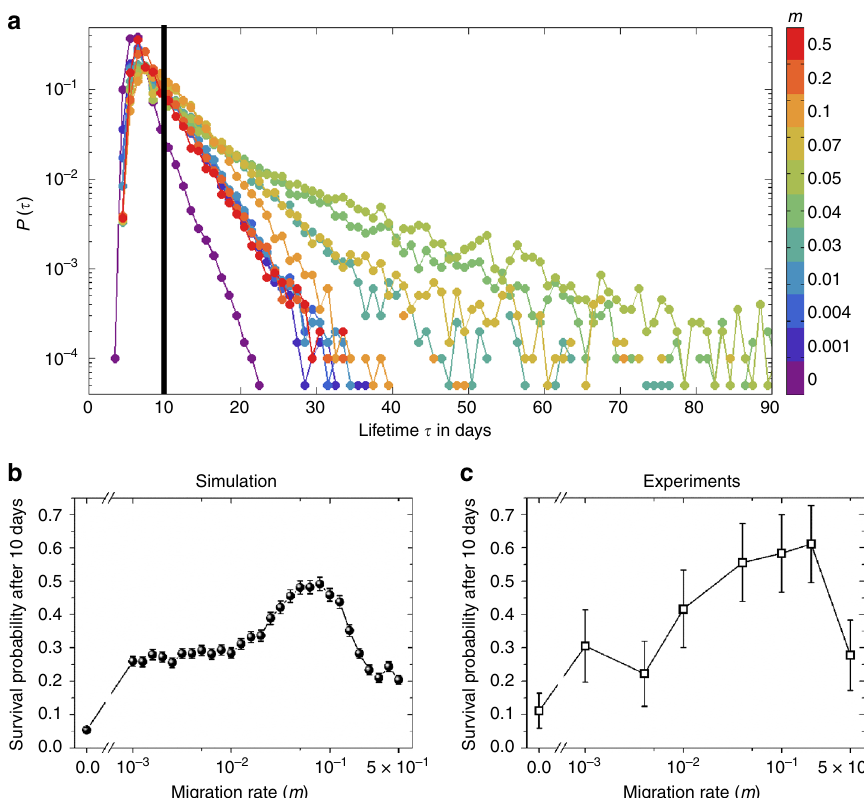
Fig. 5 Moderate levels of migration help populations survive longer in harsh environments. a Simulated probability distributions of survival times of populations in a harsh environment (10 μ g/ml of ampicillin, 16 μ g/ml of chloramphenicol) for various migration rates. The distributions were generated from 6000 simulation runs with initial conditions distributed around the three phases of the period-3 oscillations observed in Fig. 4c. Connected patches were initialized in different phases to avoid minimize synchronization. P ( τ ) is de fi ned as the fraction of initial conditions that survived for τ days. Different colors represent different migration rates, as indicated in the colorbar. The survival time distributions have longer tails at intermediate migration rates. The black vertical line indicates the threshold (10 days) used for calculating the survival probability. This threshold was chosen to match the duration of the experiments. b Simulated probability of survival after 10 days in the harsh environment as a function of the migration rate. c Experimentally measured survival probability after 10 days as a function of the migration rate from 18 replicate pairs (3 biological replicates × 6 technical replicates) of co-cultures. Both b and c exhibit a maximum at intermediate migration rates, demonstrating that moderate amounts of migration help populations to survive longer in harsh environments. The error bars in b and c are standard errors of